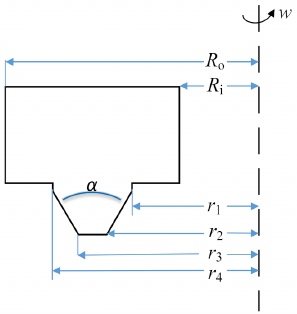
Figure 2. Equivalent radius of single conical groove friction